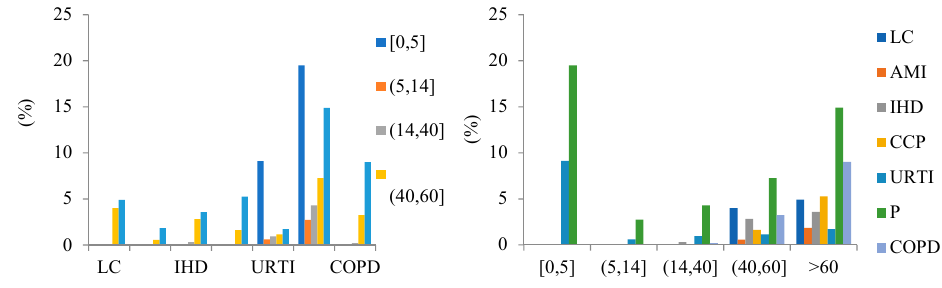
Figure 7. Diseases occurrence in different age groups.